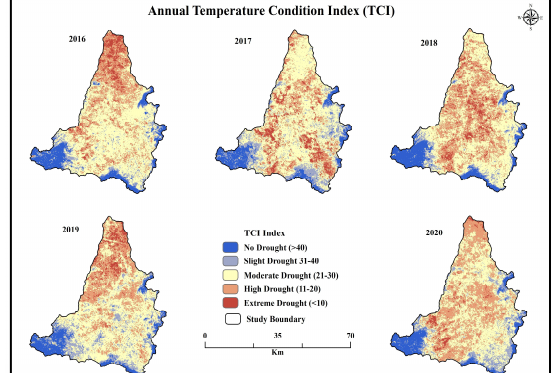
Figure 6: Annual Temperature Condition Index of 2016 to